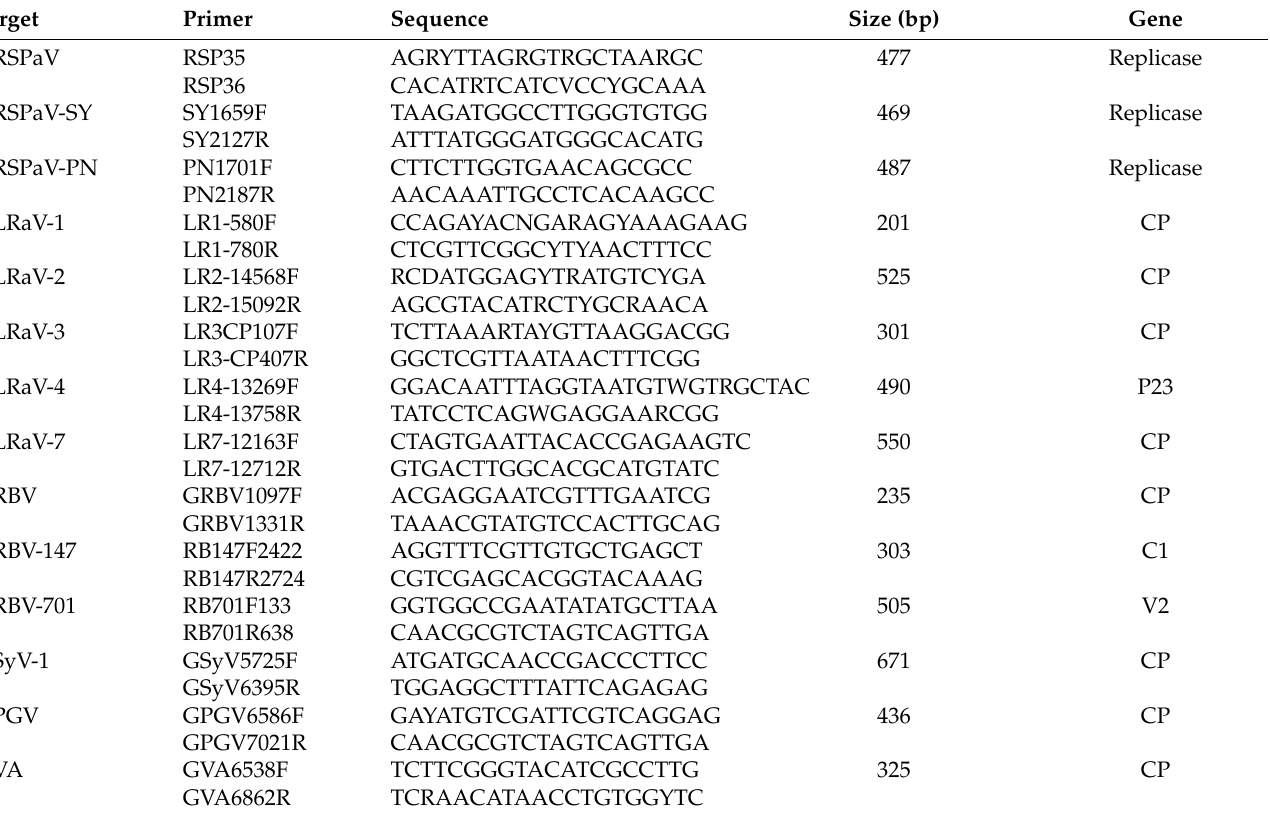
Table 1. Primers used in PCR and RT-PCR for the detection of commonly targeted grapevine viruses. All primers used here were used in a previous viral survey (Xiao et al., 2018), with the exception of the following four primer pairs, which were newly designed in this study: GRSPV-SY, GRSPaV-PN, GRBV and